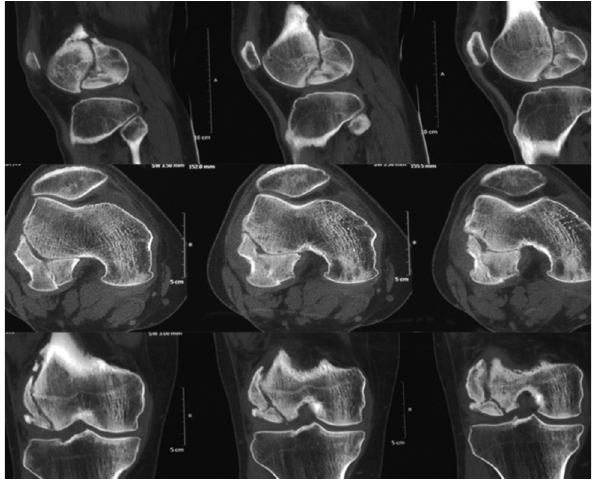
Pre-operative CT scan showing Hoffa fracture of lateral